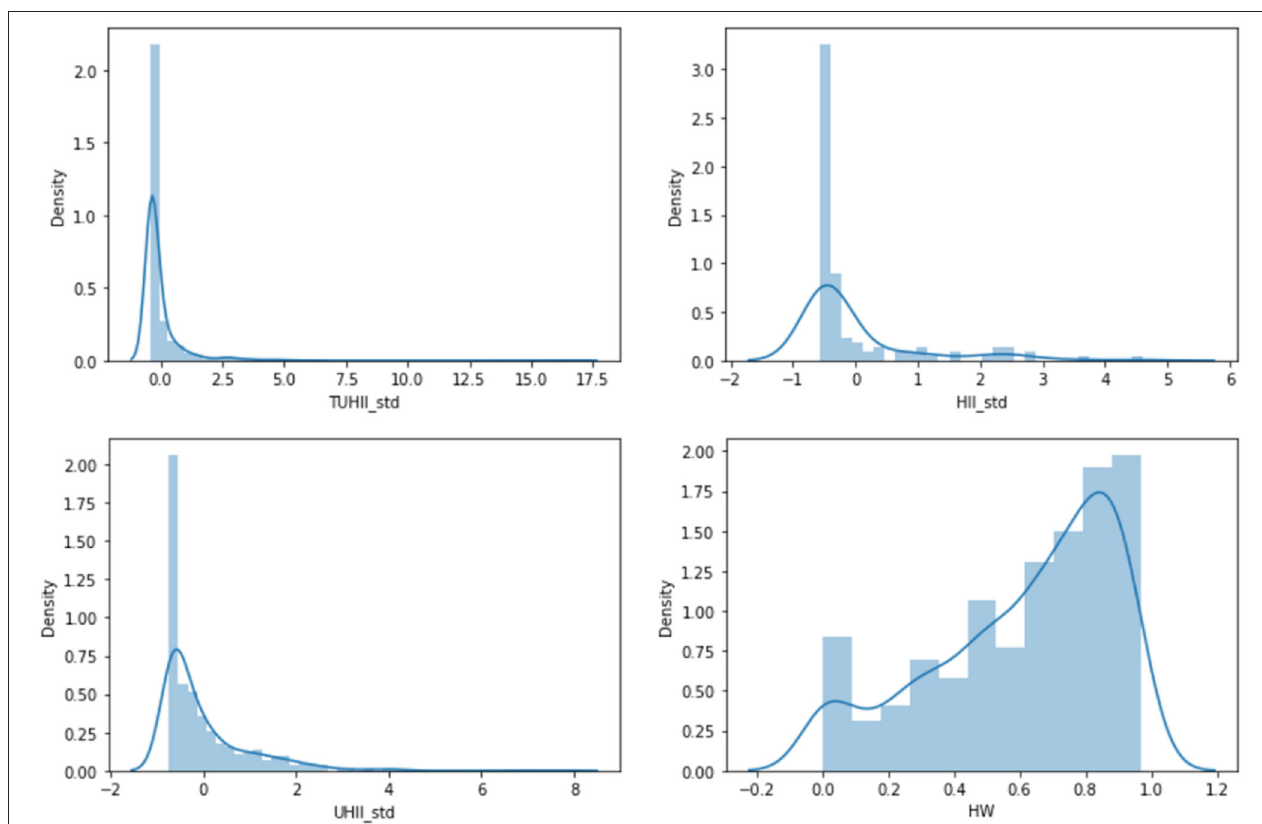
FIGURE 5 | The histogram of standardized TUHII, HII, UHII, and health